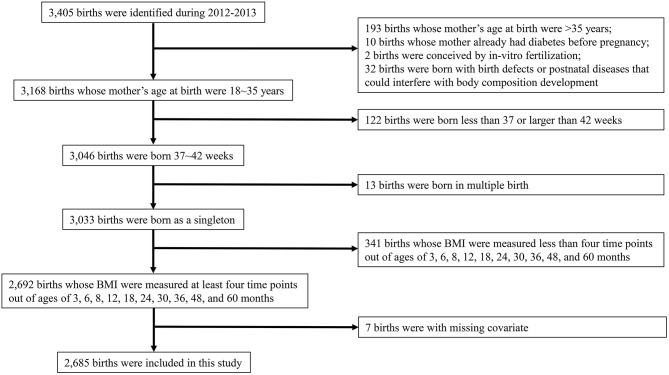
Flow chart describing the selection process of subjects for the present study.